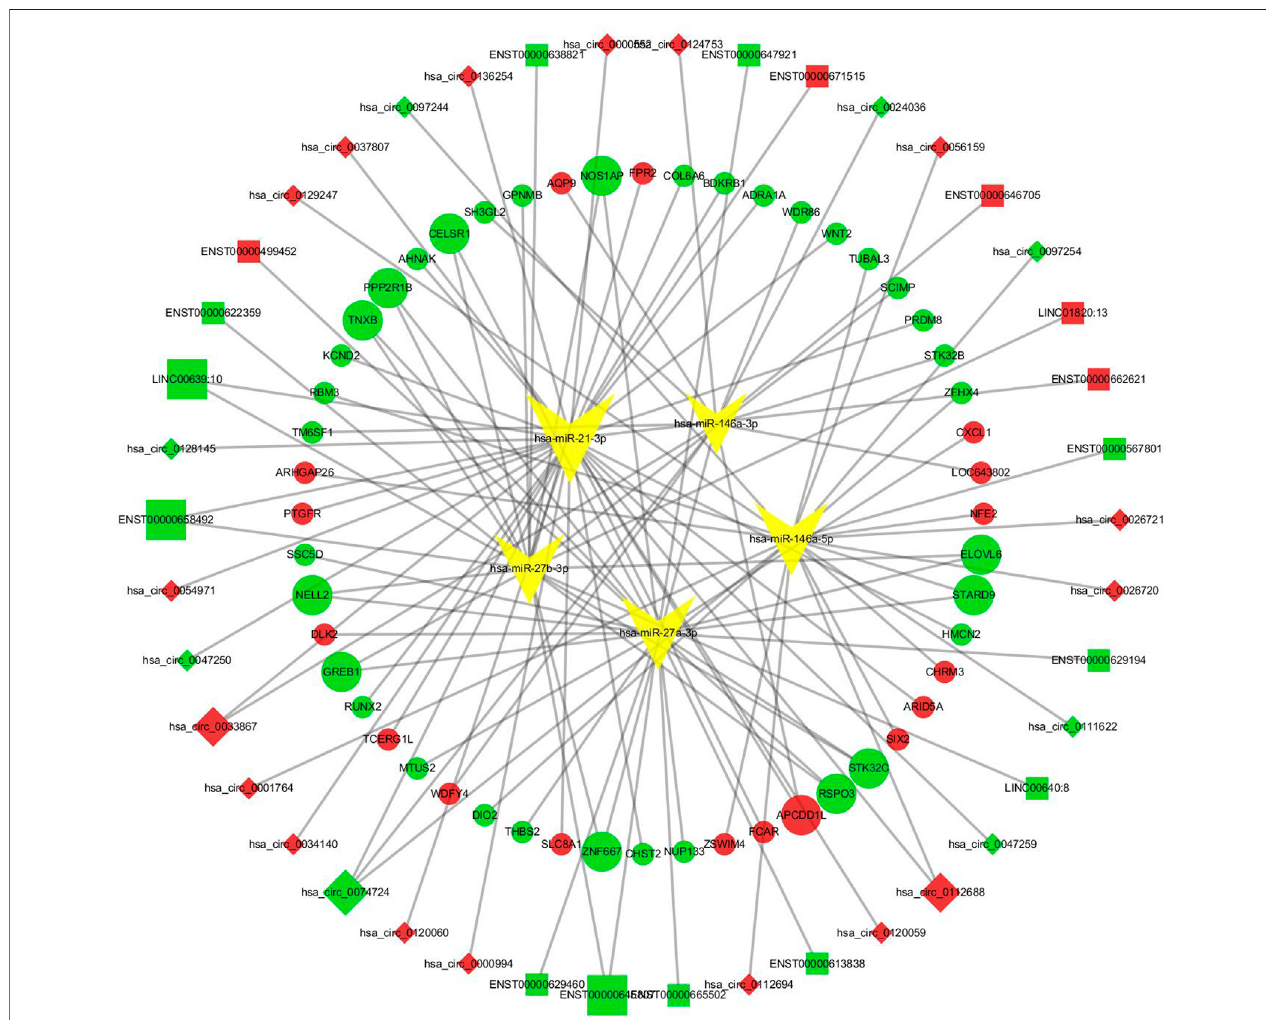
FIGURE 3 | The lncRNA/circRNA-miRNA-mRNA ceRNA network. Squares represent lncRNAs and rhombus represent circRNAs, red means that RNAs were upregulated, green means downregulated, and yellow inverted triangles represent miRNAs. Round dots represent the mRNAs; similarly, red indicates that the RNAs were upregulated, and green indicates